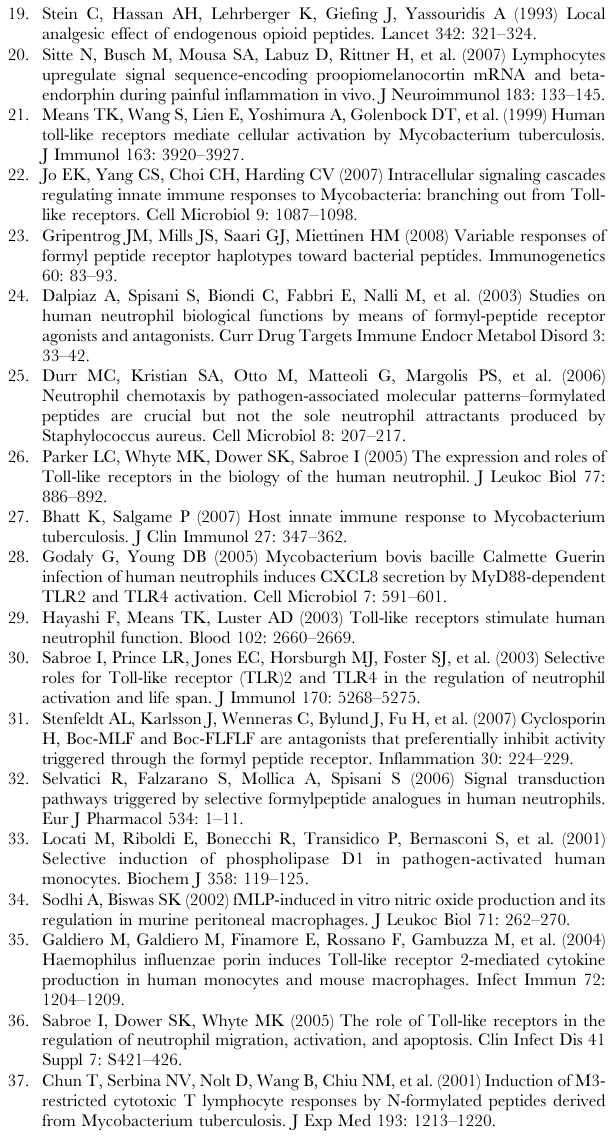
Figure S1 b -Endorphin release from neutrophils is triggered by mycobacteria and FPR agonists but not by toll like receptor-2 or toll like receptor-4 agonists. [A–C] Rat and human neutrophils as well as CD14 + human monocytes were incubated with heat- inactivated Mycobacterium butyricum ( Myco. but. ), and b